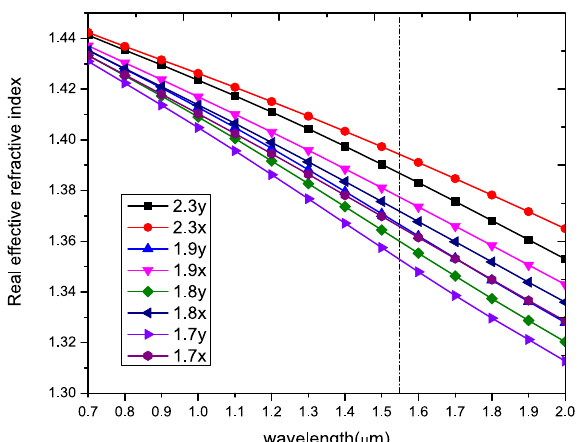
Fig. 12 Change of real effective index as a function of wavelength Λ of 1.7 µm, 1.8 µm, 1.9 µm and 2.3